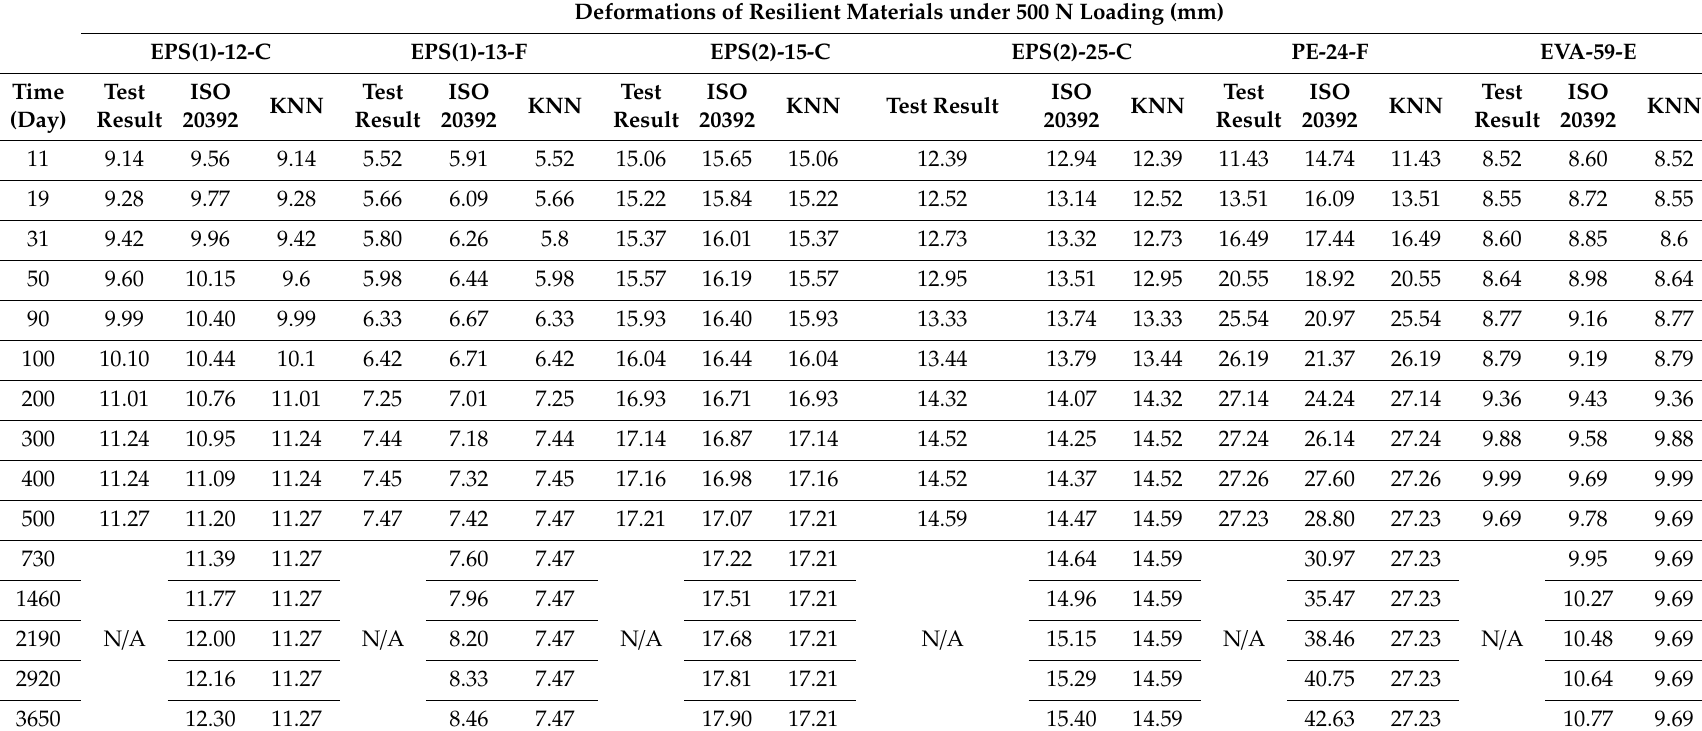
Table 5. Deformations of resilient materials under 500 N